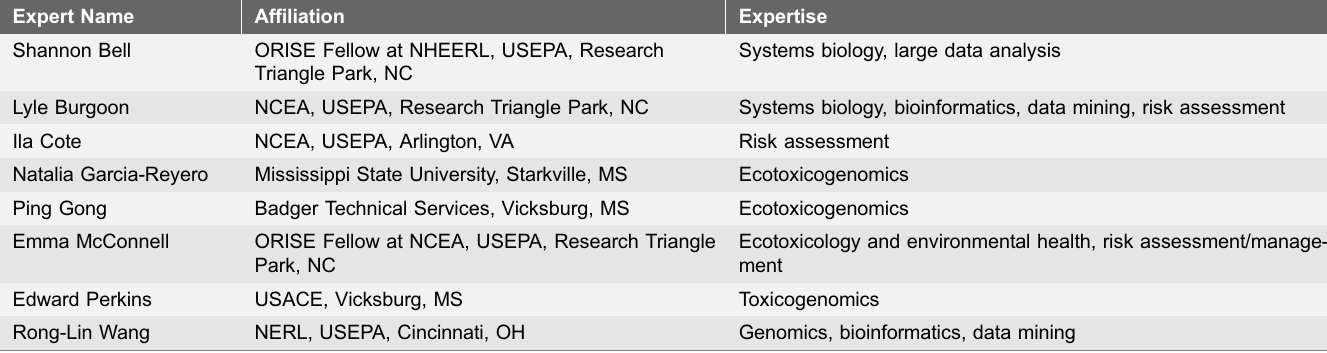
Table 3. Experts who participated in editing and validating the SOAR tool, their affiliations, and